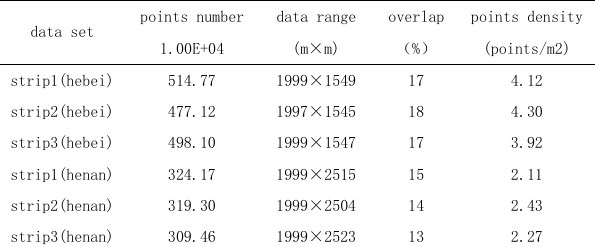
Table 1. Properties of the test data